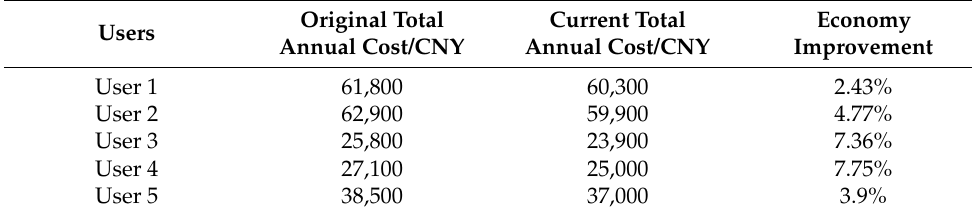
Table 4. Cost-sharing